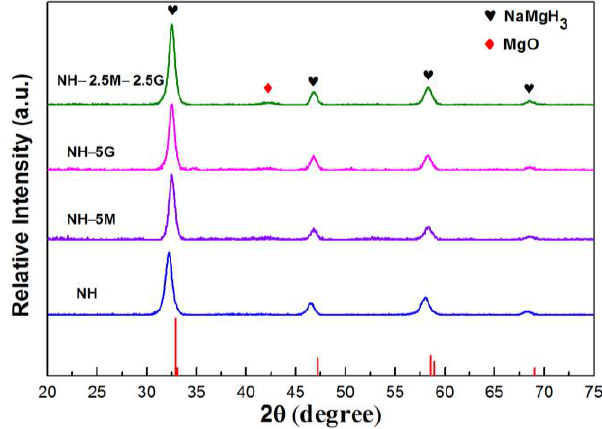
Figure 1. The XRD patterns of as-prepared NaMgH 3 hydride and NH-CM composites.